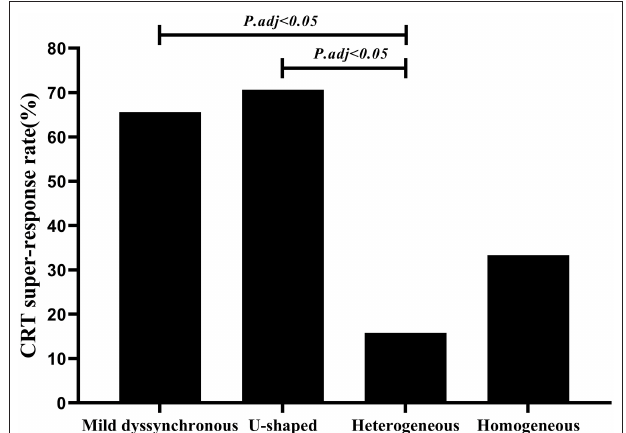
FIGURE 4 | Comparison of CRT super-response rate among four groups. Mild dyssynchronous and U-shaped groups had significantly higher CRT super-response rates than the heterogeneous group ( P .adj < 0.05). adj, adjusted. Multiple comparisons was adjusted by Bonferroni’s